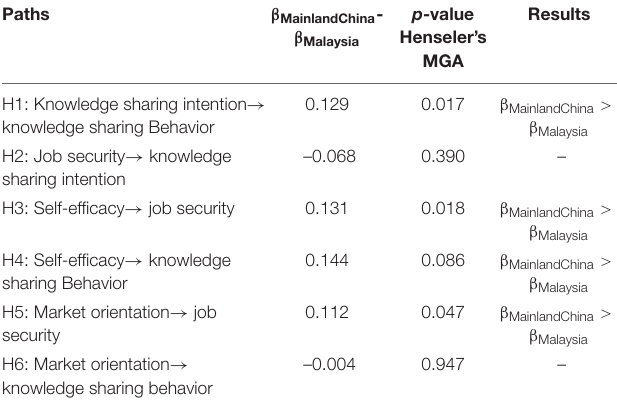
TABLE 3 | Multigroup analysis